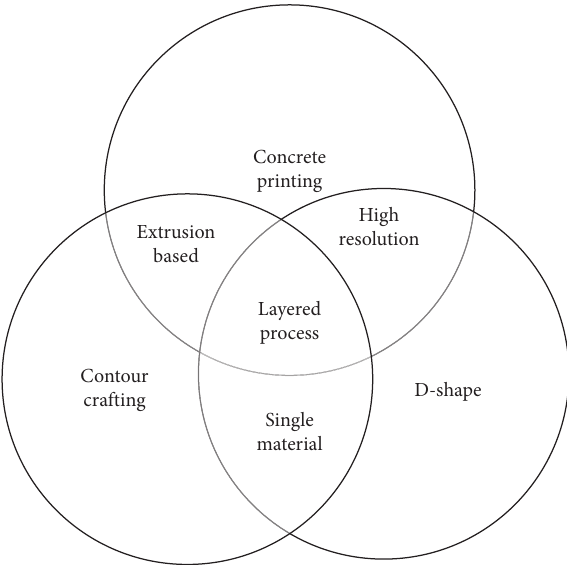
Figure 1: Similarities between the processes [7].